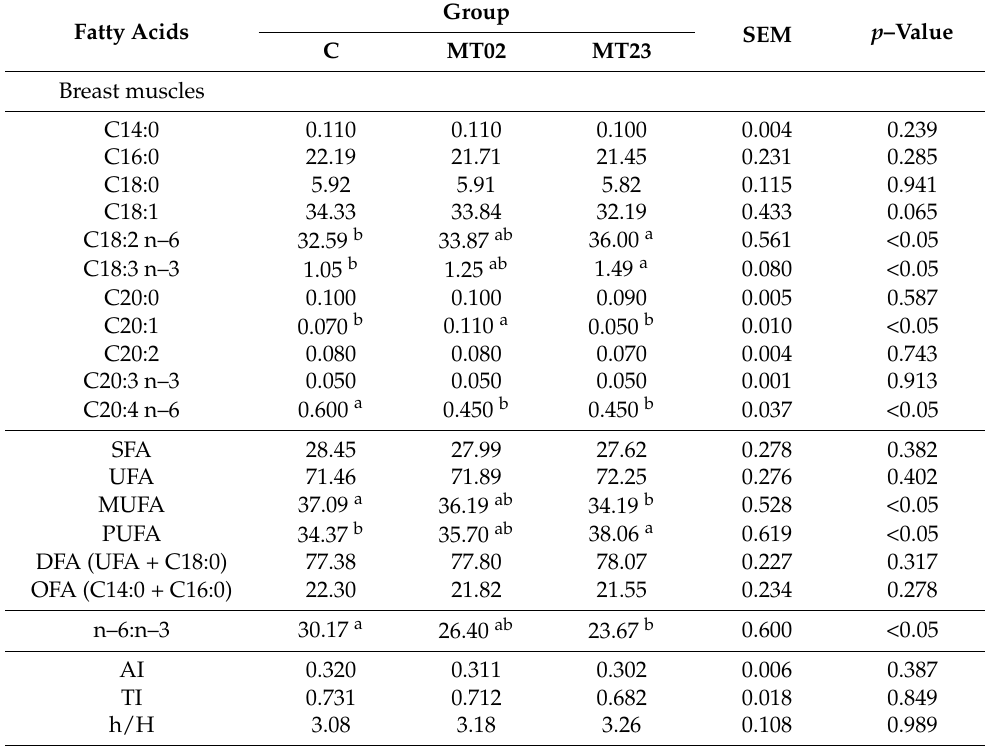
Table 6. Fatty acids profile (% total FA) of